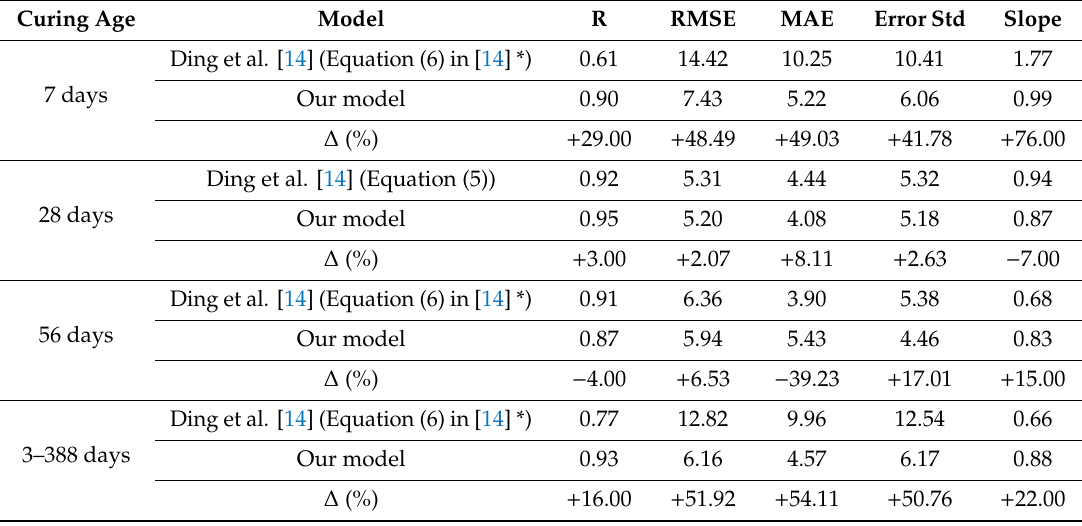
Table 6. Comparison between ANFIS-TLBO / P and existing formula in the literature. Curing